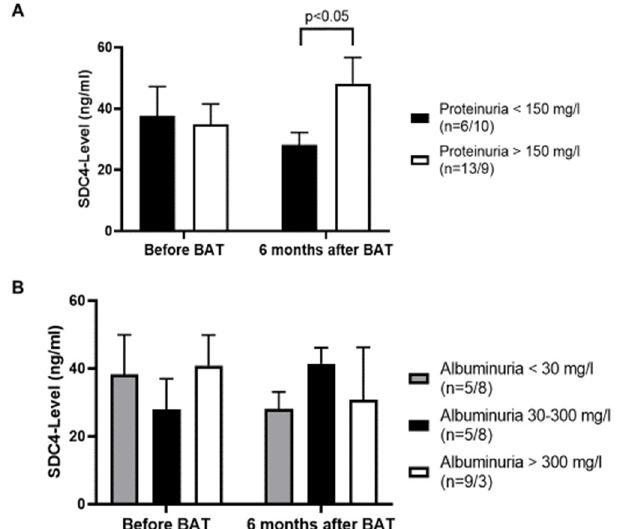
Figure 4. ( A ): Six months after BAT implantation patients with a proteinuria >150 mg/L show higher levels of serum SDC4. ( B ): Serum SDC4-levels do not correspond to albuminuria of patients suffering from resistant HTN. First number of n represents patient number before BAT. Second number of n represents patient number 6 months after BAT implantation. Values are given as means ± SEM.